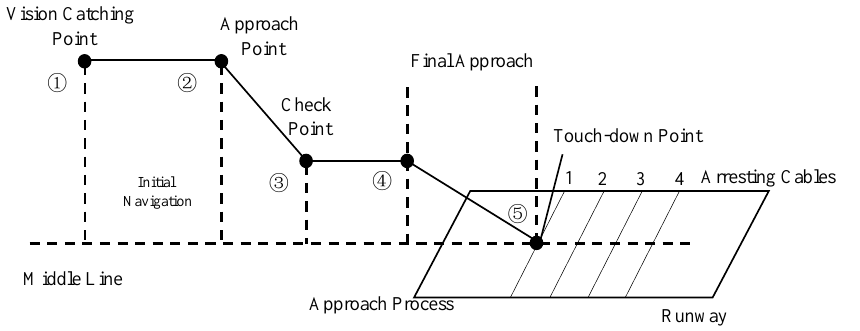
Figure 4. Fixed-wing UAS landing process.